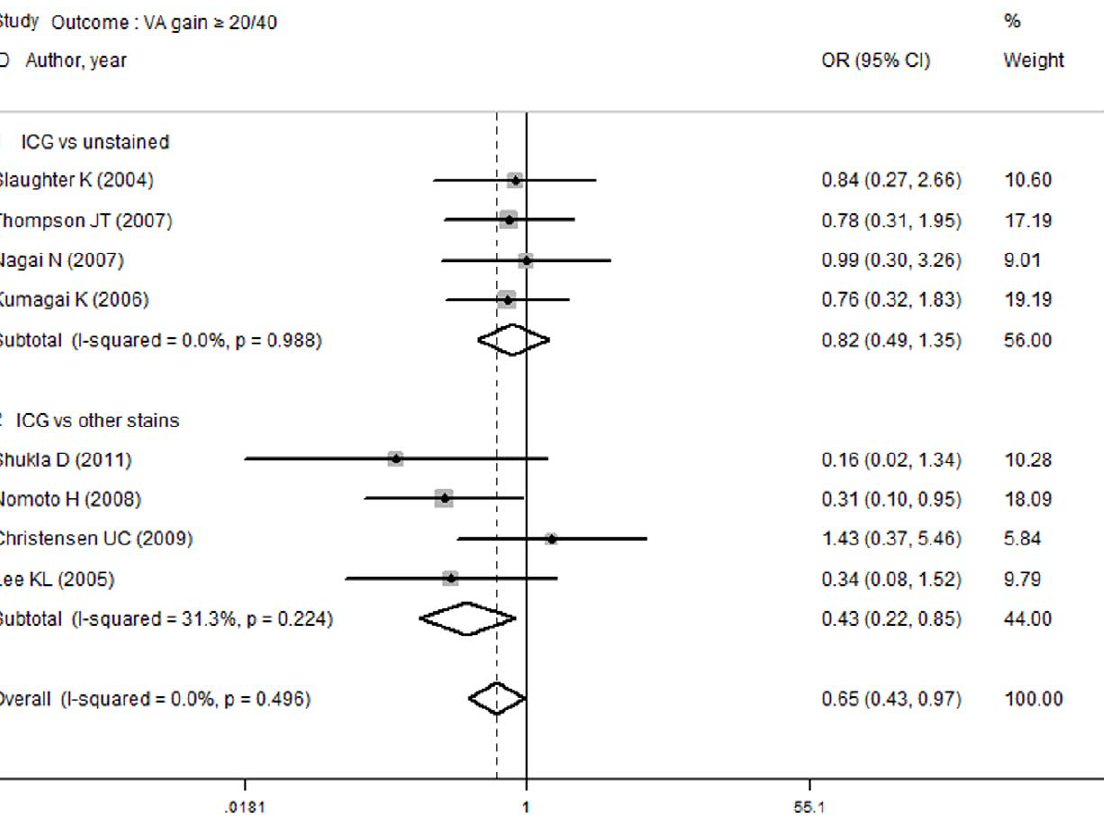
Figure 4. Subgroup analyses of outcome VA gain 20/40 in ICG group versus unstained and other stains groups. The lower rate of VA gain $ 20/40 was observed in ICG group compared with other stains group while no difference was observed in ICG group compared with unstained group.